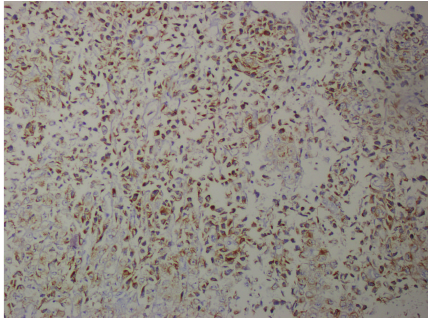
Figure 3: Immunohistochemically, HMB-45 positive tumor cells (DAB ×